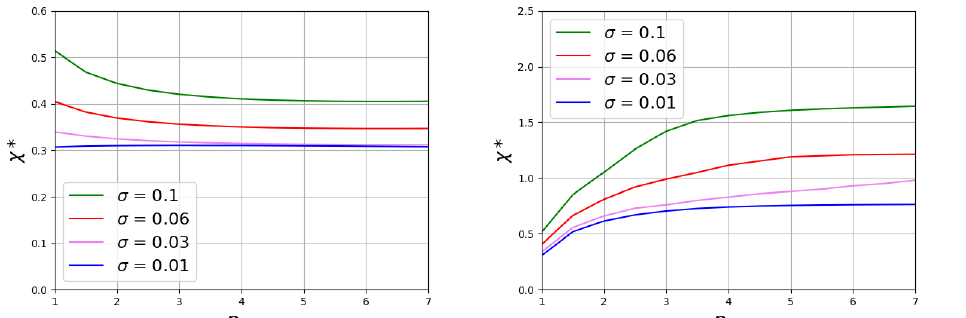
Figure 6. Solvent selectivity strength values as a function of Kuhn segment length of chains. In the ( left figure ), the stiffness of both chains changes simultaneously p = p A = p B . In the ( right figure ), only the stiffness of the long responsible chains p = p B increases, while chains A remain flexible p A = 1. The given data corresponds to the value of ratio N B / N A =